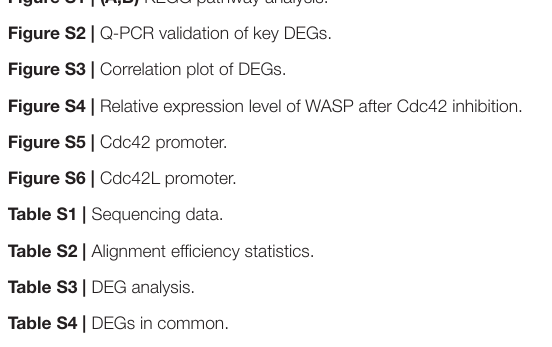
Figure S1 | (A,B) KEGG pathway analysis. Figure S2 | Q-PCR validation of key DEGs. Figure S3 | Correlation plot of DEGs. Figure S4 | Relative expression level of WASP after Cdc42 inhibition. Figure S5 | Cdc42 promoter. Figure S6 | Cdc42L promoter. Table S1 | Sequencing data. Table S2 | Alignment efficiency statistics. Table S3 | DEG analysis. Table S4 | DEGs in